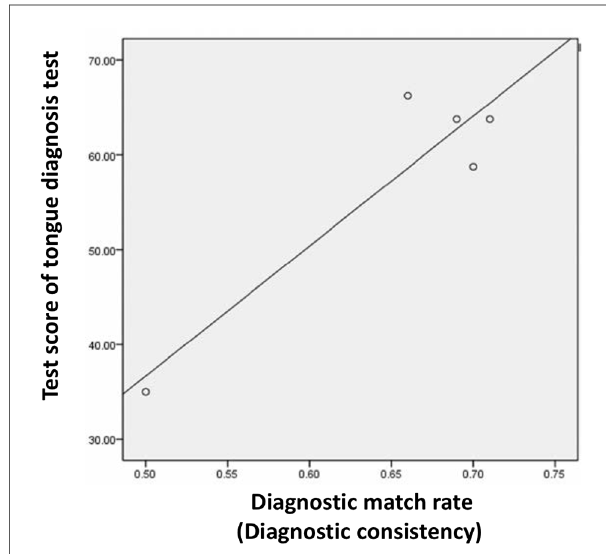
FIGURE 6 Correlation between diagnostic consistency and test score (Study 1). A high correlation was found between the diagnostic match rate and tongue diagnosis test score (Pearson ’ s correlation coef fi cient, 0.927; p